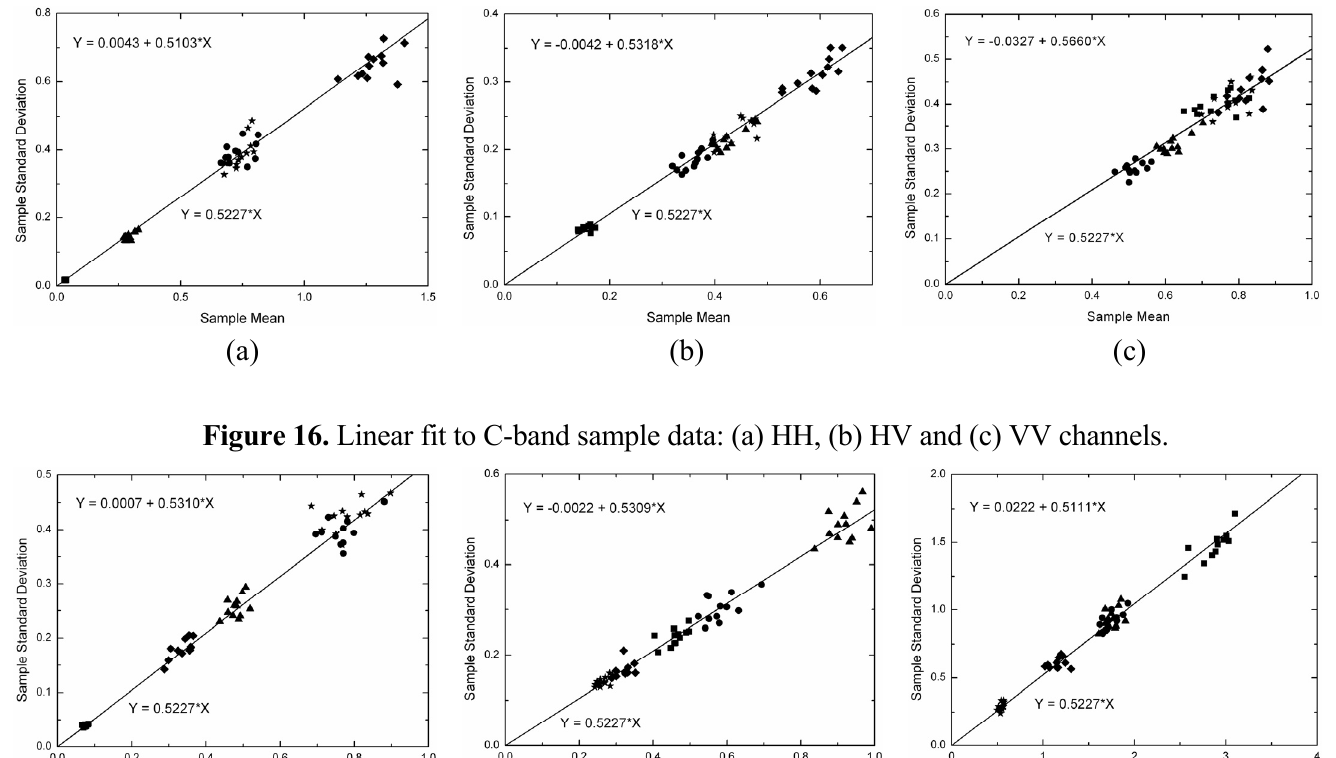
Figure 15. Linear fit to L-band sample data: (a) HH, (b) HV and (c) VV channels.